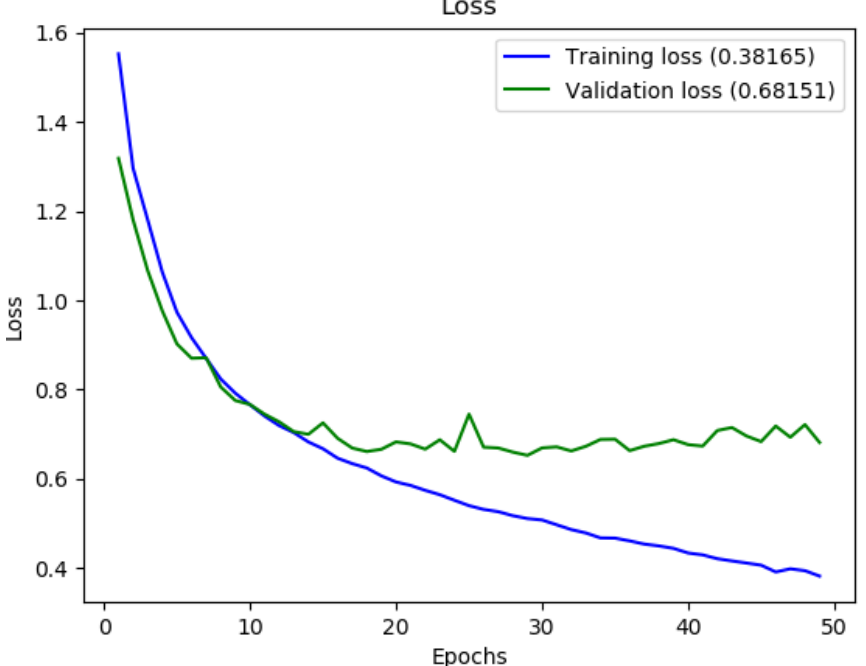
Figure 5. Loss graph of the network in [21], trained with the FER2013 database with the FER+ annotations using the data augmentation and the z-score normalization. Figure from